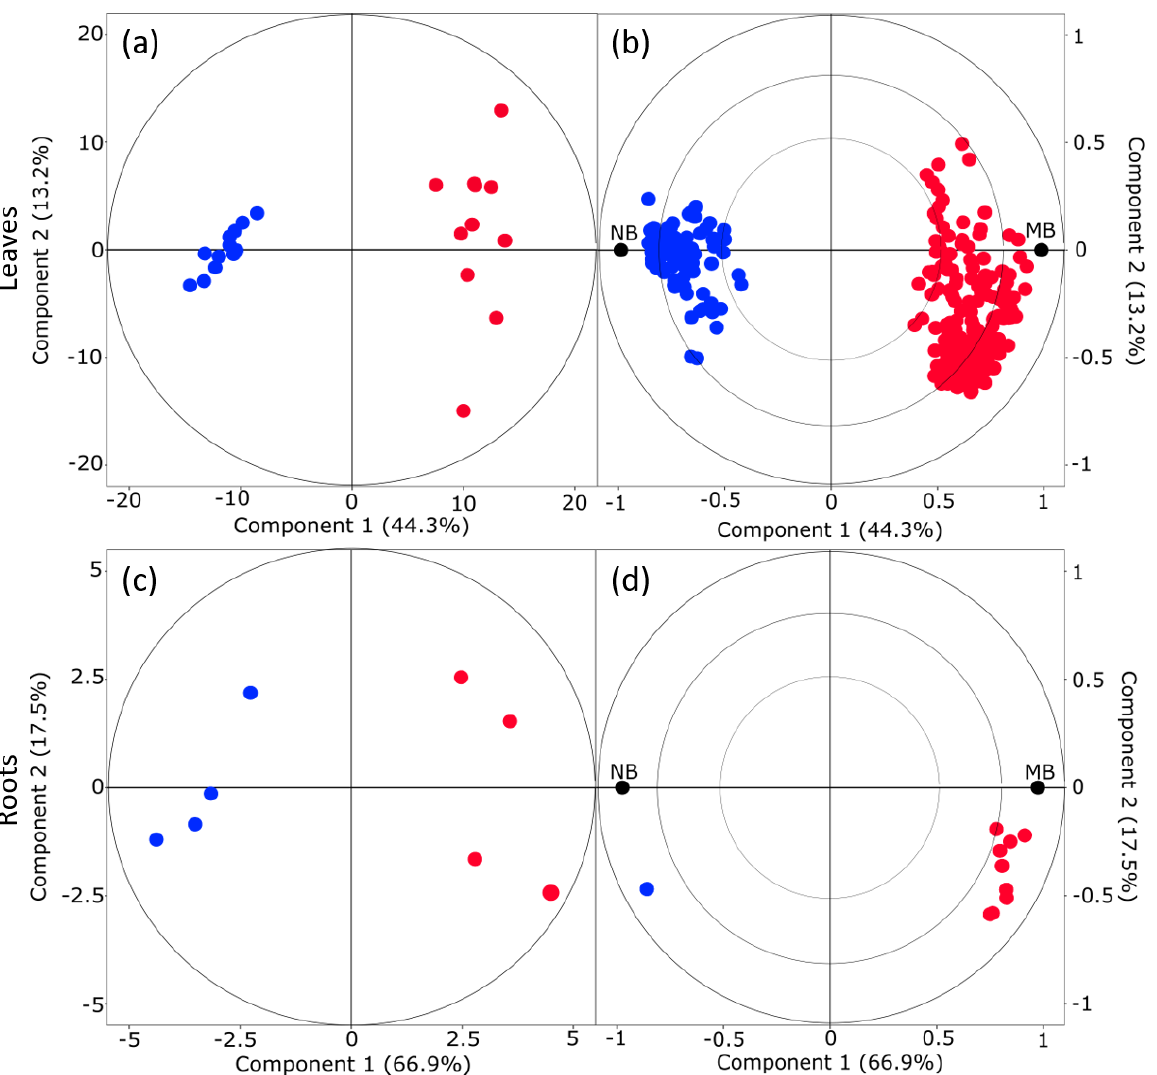
Figure 3. OPLS-DA score plots ( a , c ) and loading plots ( b , d ) show the effect of beetle infestation on mycorrhized poplar trees for leaves ( a , b ) and roots ( c , d ). NB = non-mycorrhizal poplars exposed to leaf beetles, MB = mycorrhizal poplars exposed to leaf beetles. The discriminant mass features and metabolites are listed in Supplementary Table S2.